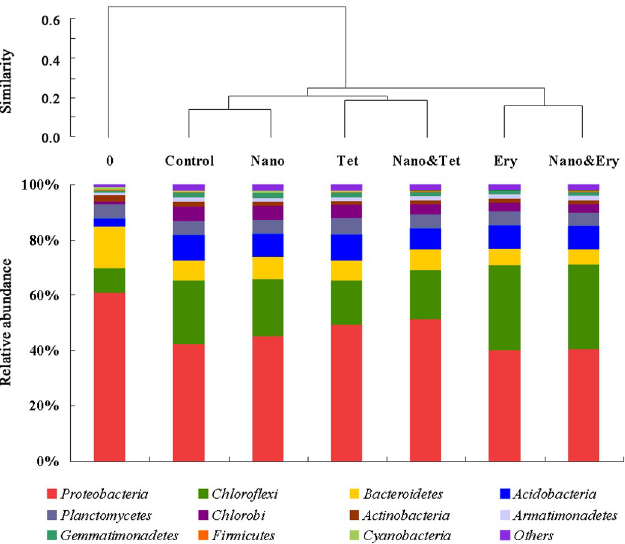
Fig 3. Relative abundance and hierarchical cluster analysis of all samples at phylum